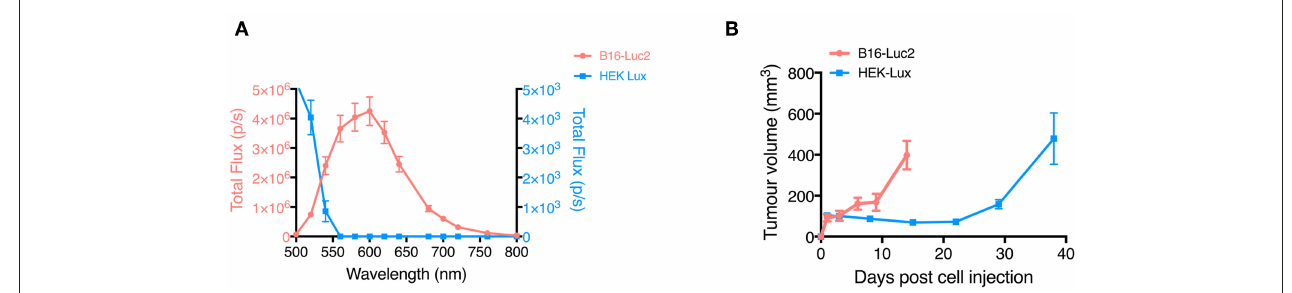
FIGURE 2 | Characterization of emission spectra of B16-Luc2 and HEK-Lux cells and tumor growth curves. (A) Emission spectrum of B16-Luc2 and HEK-Lux cells. Bioluminescence images were acquired from 500 to 840nm for 30s (B16-Luc2) or 180s (HEK-Lux). Results are expressed as total flux (photons/s) in the ROI, n = 3.